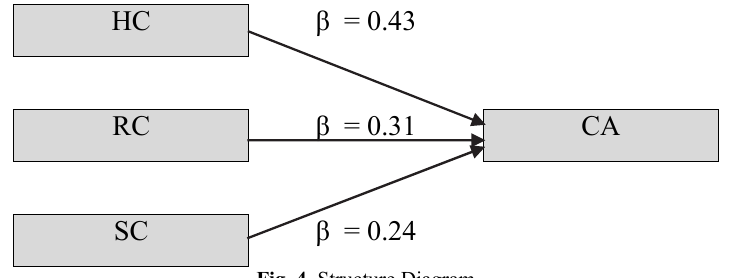
Fig. 4. Structure Diagram